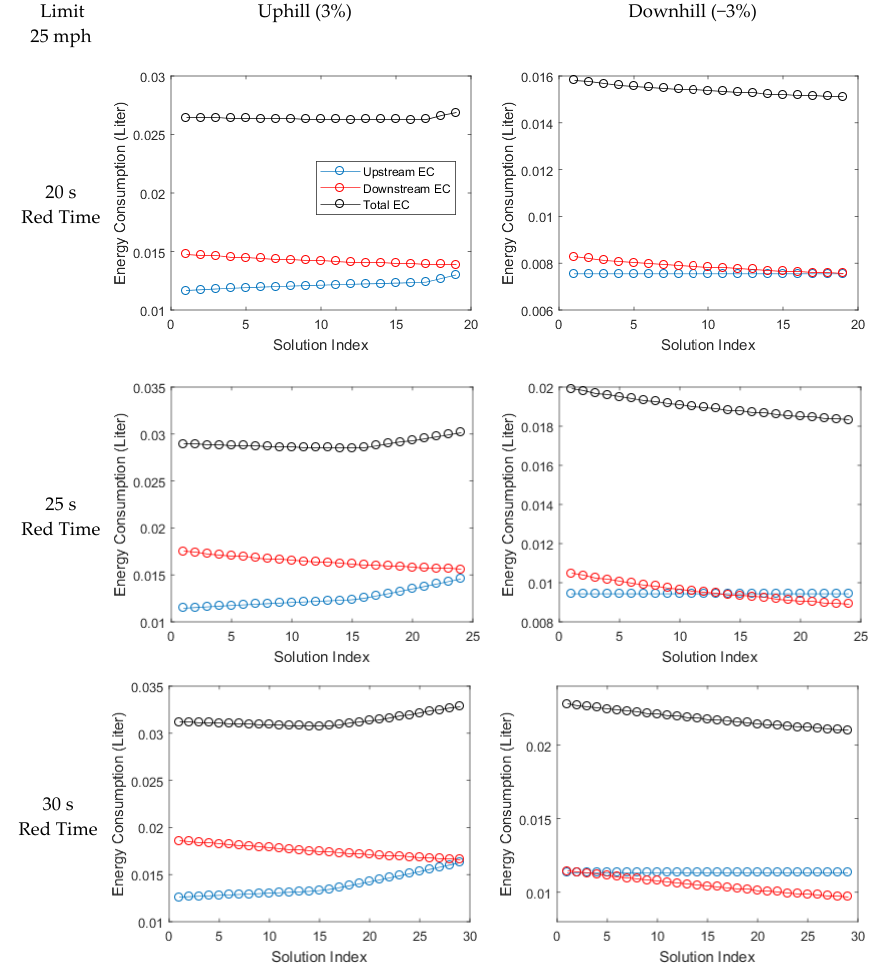
Figure 5. Honda Fit ICEV Eco ‐ CACC ‐ I fuel consumption for a speed limit of 25 mph.